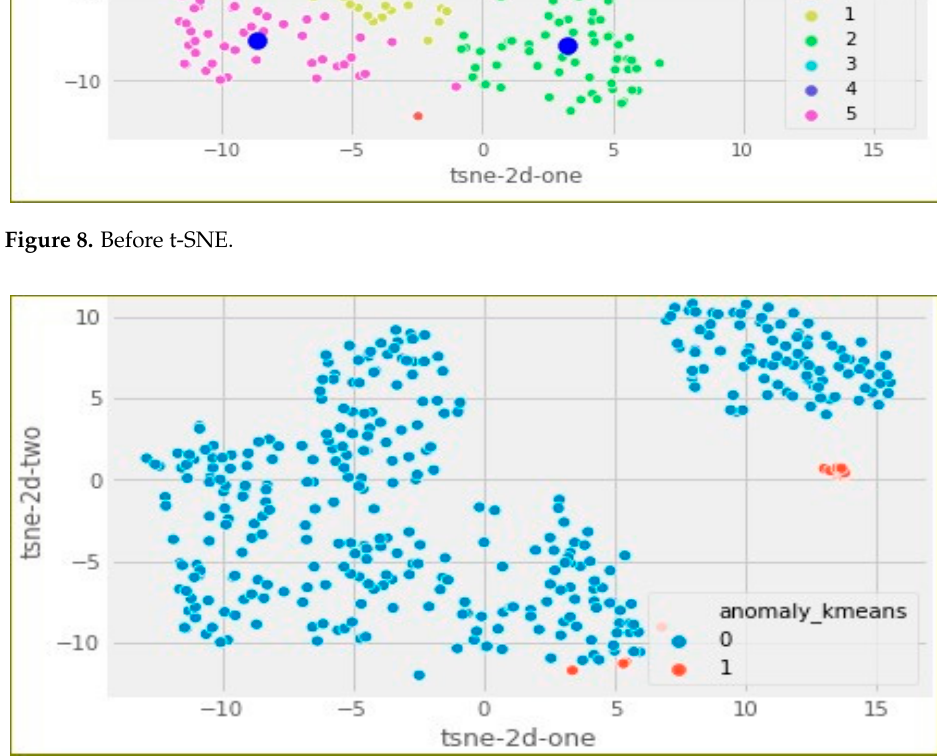
Figure 9. Result of t-SNE.